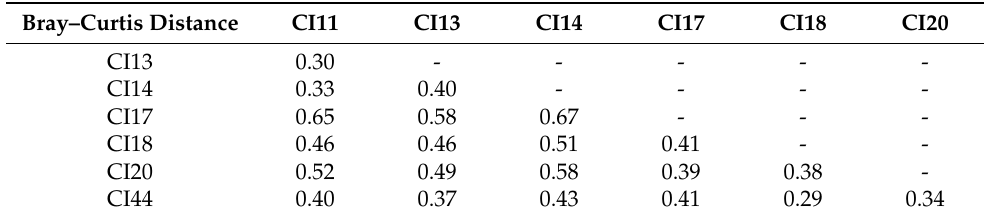
Figure 5. A heat map illustrating the relative abundance and the ubiquity of each of the 77 ASVs detected from the savannah soils in Northern C ô te d’Ivoire. Table 4. The measure of the beta-diversity as indicated by the Bray–Curtis distance.